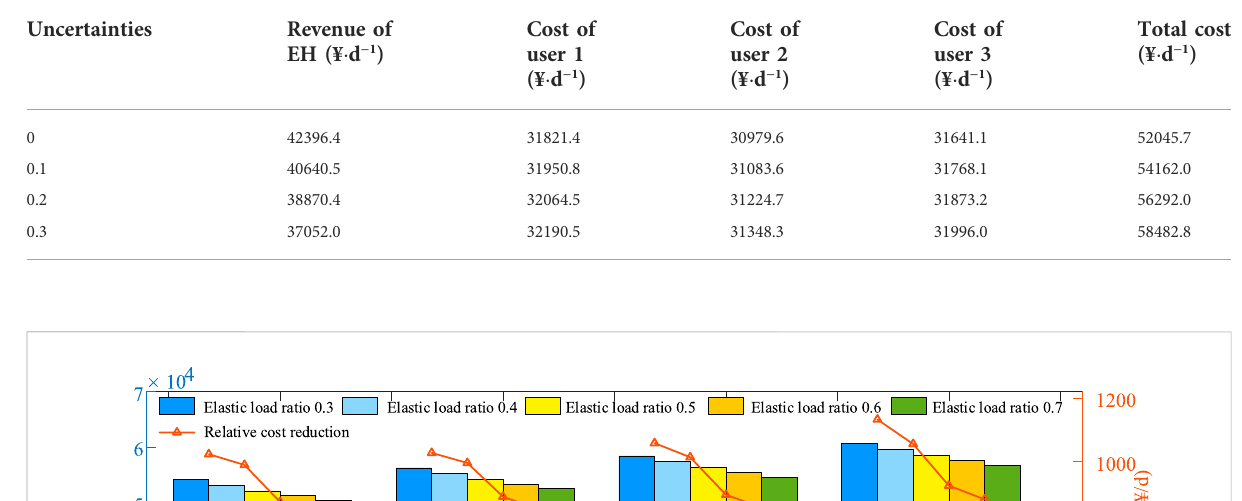
TABLE 2 The cost of decentralized robust optimal dispatch for each agent under different uncertainties.